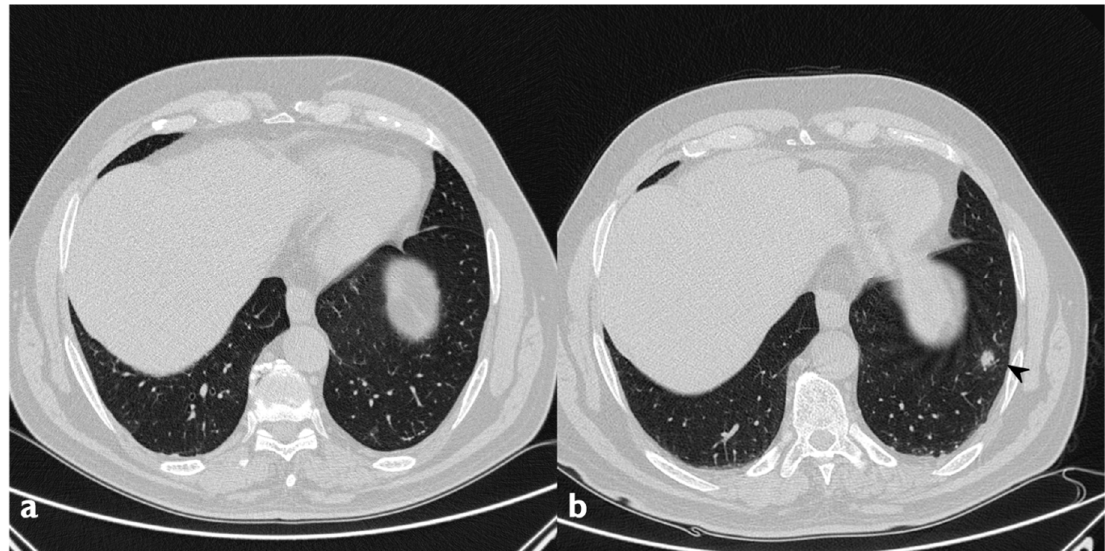
Figure 11. On the left ( a ): baseline HRCT; peripheral solid nodule in the right lower lobe (arrowheads). On the right ( b ): HRCT after oral corticosteroid (OCS) therapy; the previous nodule is no longer present.